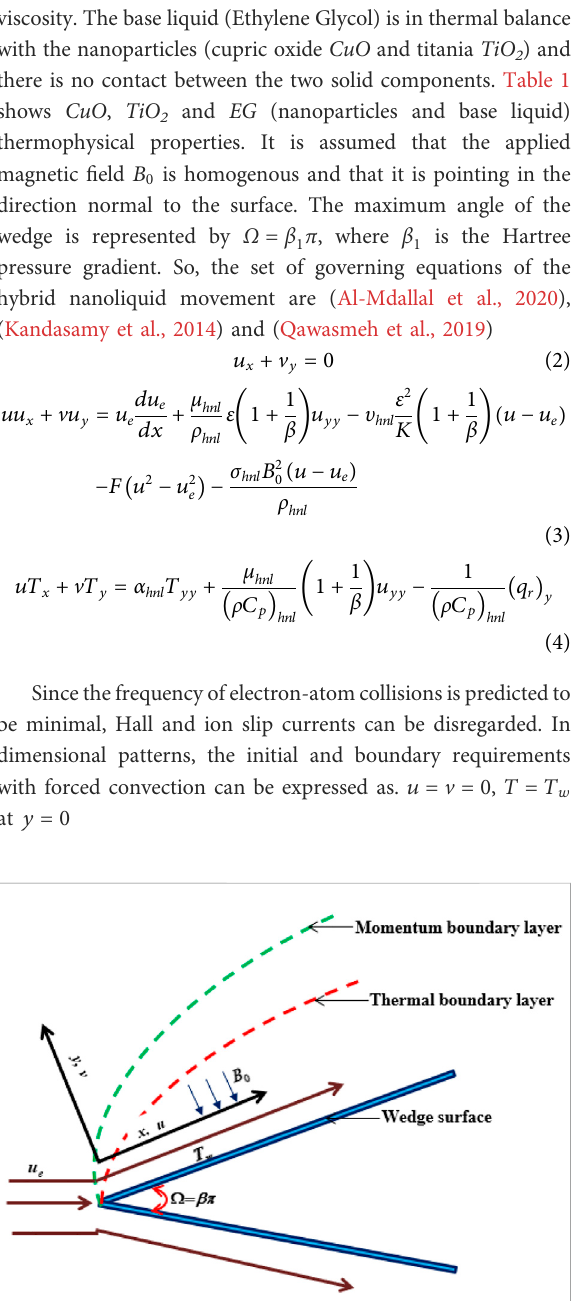
FIGURE 1 Physical Con fi guration.